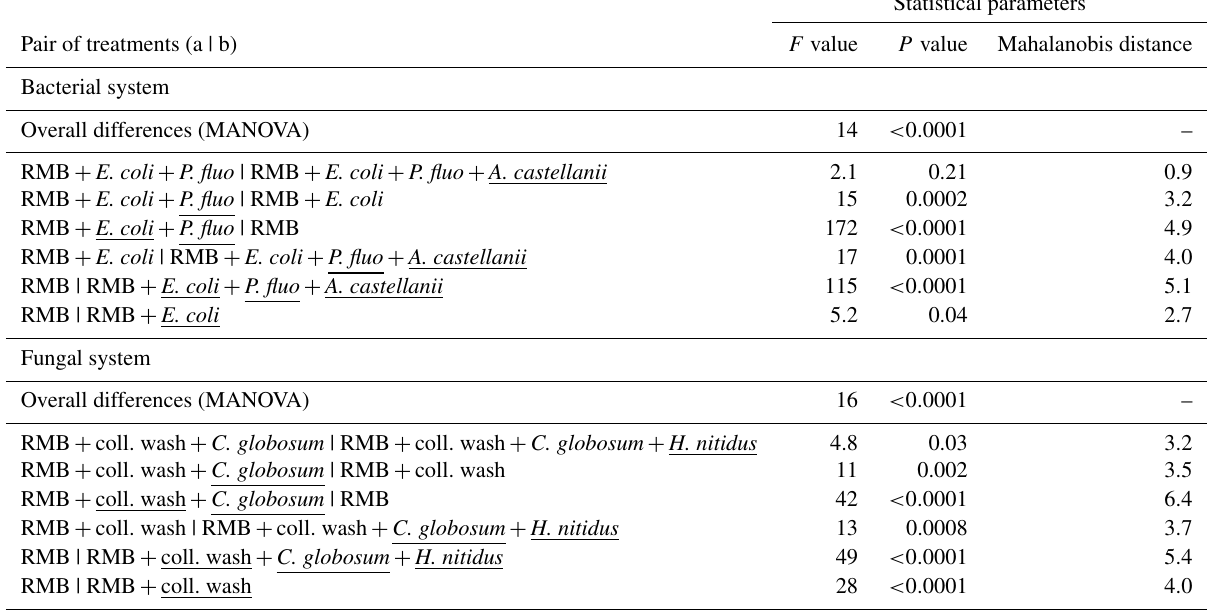
Table 2. Effect of bacterial and fungal consumer–prey inoculations on bacterial community composition. Differences in the composition of bacterial PLFAs between treatments were analysed using non-metric multidimensional scaling (NMDS), followed by discriminant function analysis (DFA). Overall differences in terms of bacterial PLFA composition (eight markers) within the bacterial and fungal systems were first analysed by MANOVA. Pairwise differences between treatments were further investigated using Mahalanobis distances. Inoculation treatments are underlined. RMB: remaining microbial background; coll. wash: collembolan wash; P. fluo : P. fluorescens